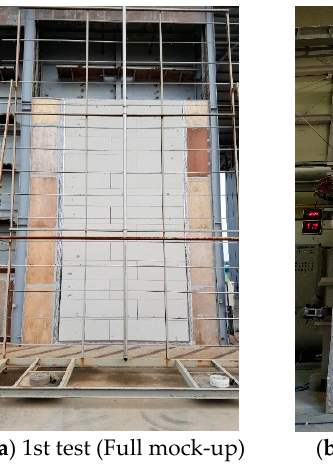
Figure 4. Test procedures of the building envelope performance.